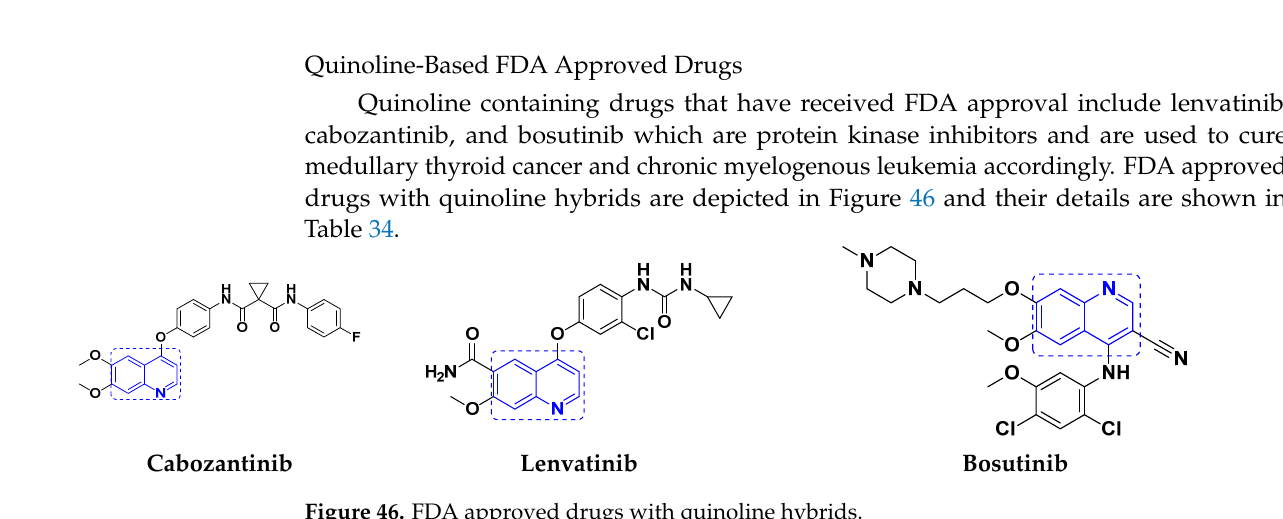
Figure 45. Quinoline ‐ based gallium(III) hybrid ( 41 ).